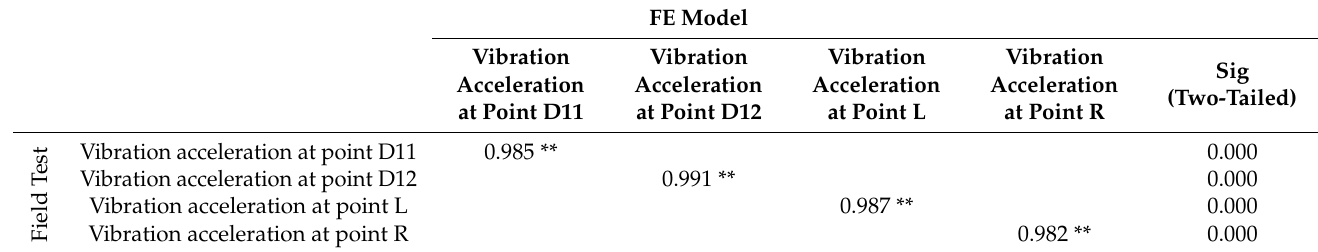
Table 4. Correlation matrix of field data and numerical